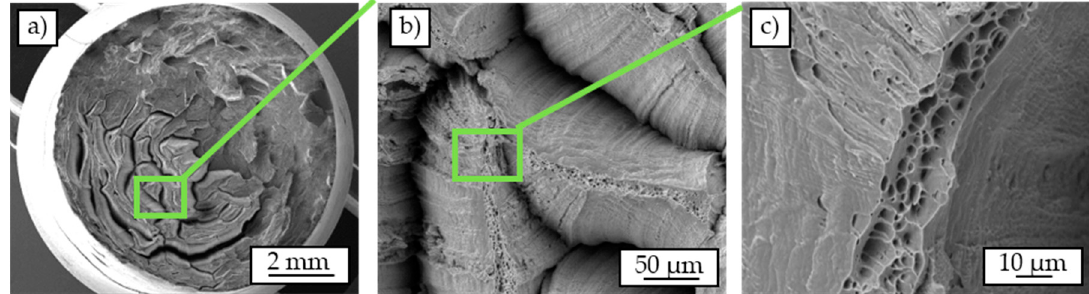
Figure 12. Scanning electron micrographs of a chip-based specimen tested in a constant amplitude test ( σ a = 120 MPa): overview ( a ), detached chips ( b ), fracture pattern on chips ( c